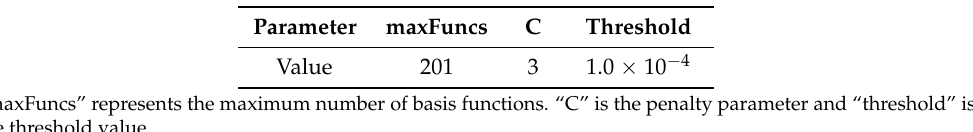
Table 2. The optimal parameters for the multivariate adaptive regression splines (MARS) model.